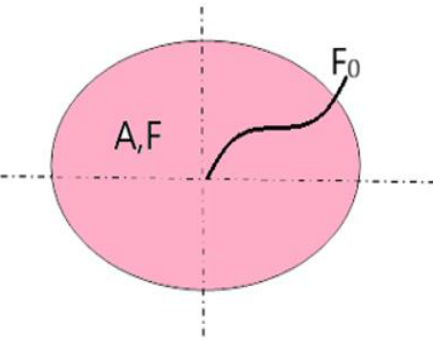
Figure 6. Integral force in the system.